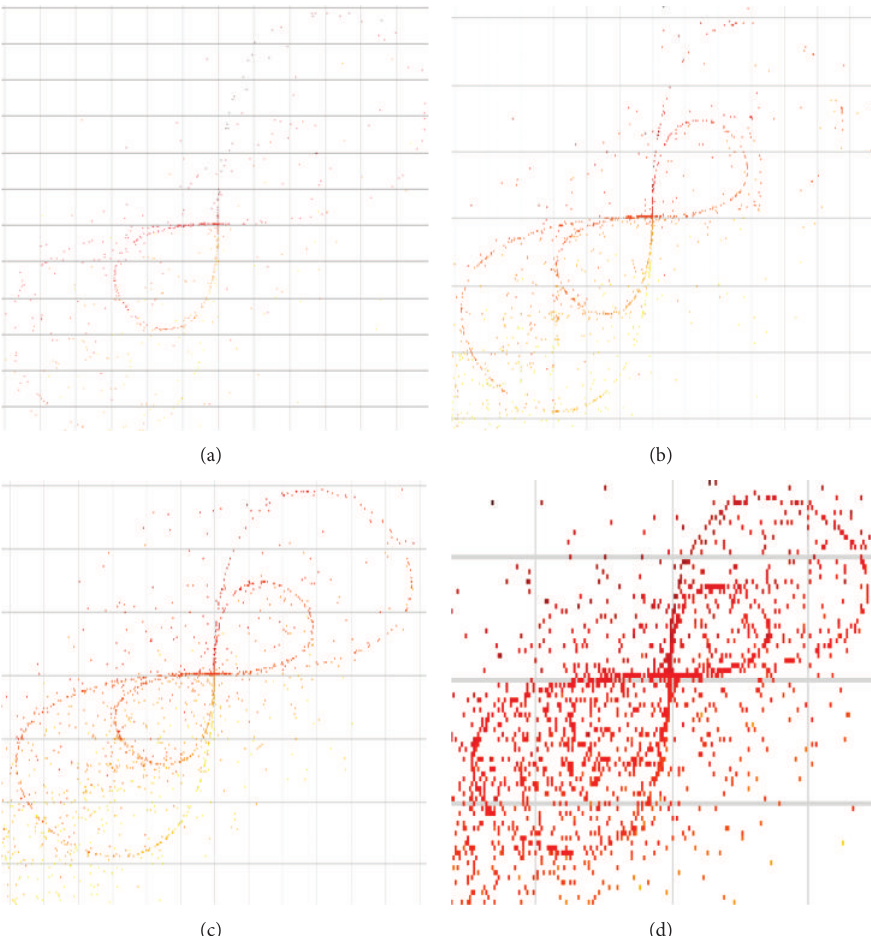
Figure 12: (a) The initial low temperature segment, (b) the first intermediate process, (c) the second intermediate process, and (d) the third intermediateprocess.(Thehorizontalaxisandverticalaxisare,respectively, 𝑥(𝑡) -DTGand 𝑥(𝑡+1) -DTG, thecolourindicatedthedimension).